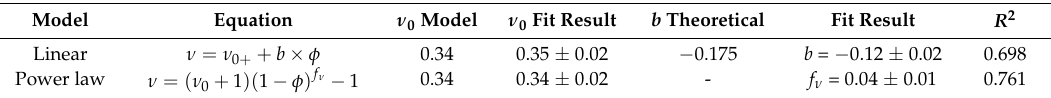
Table 2. Fitting results for the experimental data for the linear model and the power law model with R squared (coefficient of